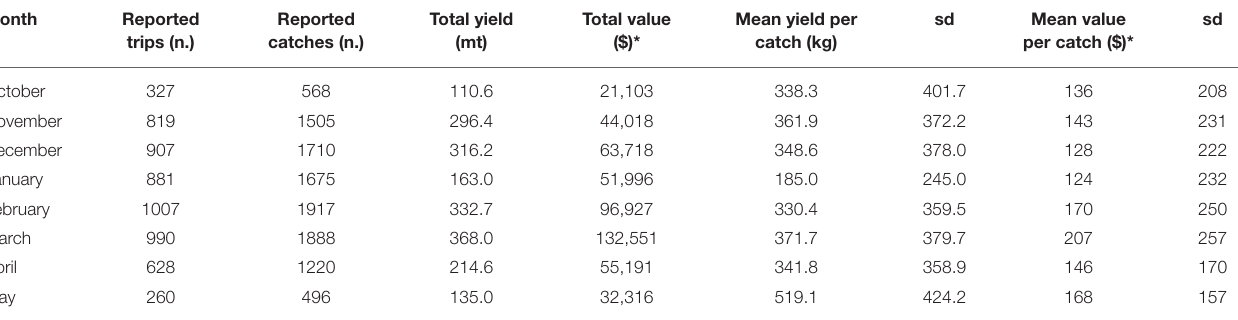
TABLE 4 | Monthly mean weight and value per haul for the purse seine fishery calculated from logbook data of 36 vessels. Month Reported trips (n.)